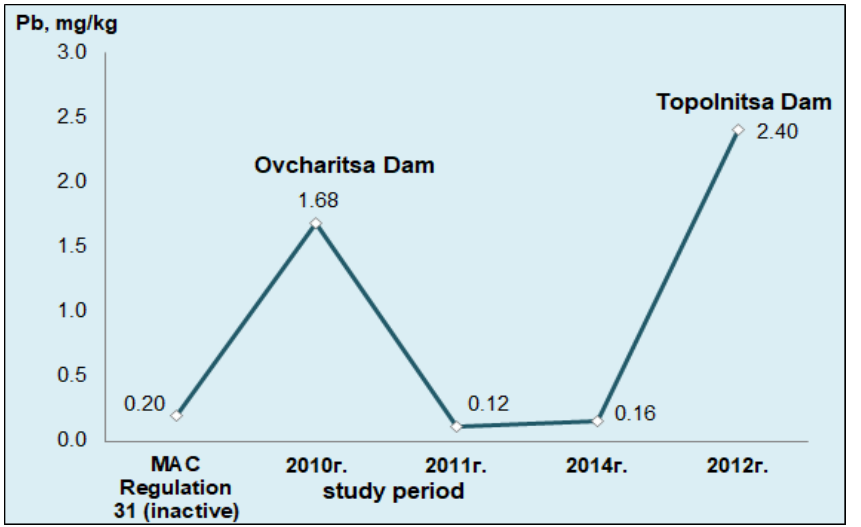
Figure 3. Content of Pb in liver samples of common carp inhabiting Ovcharitsa Dam in the period of 2010–2014 [4], as well as Topolnitsa Dam in 2012 [101].